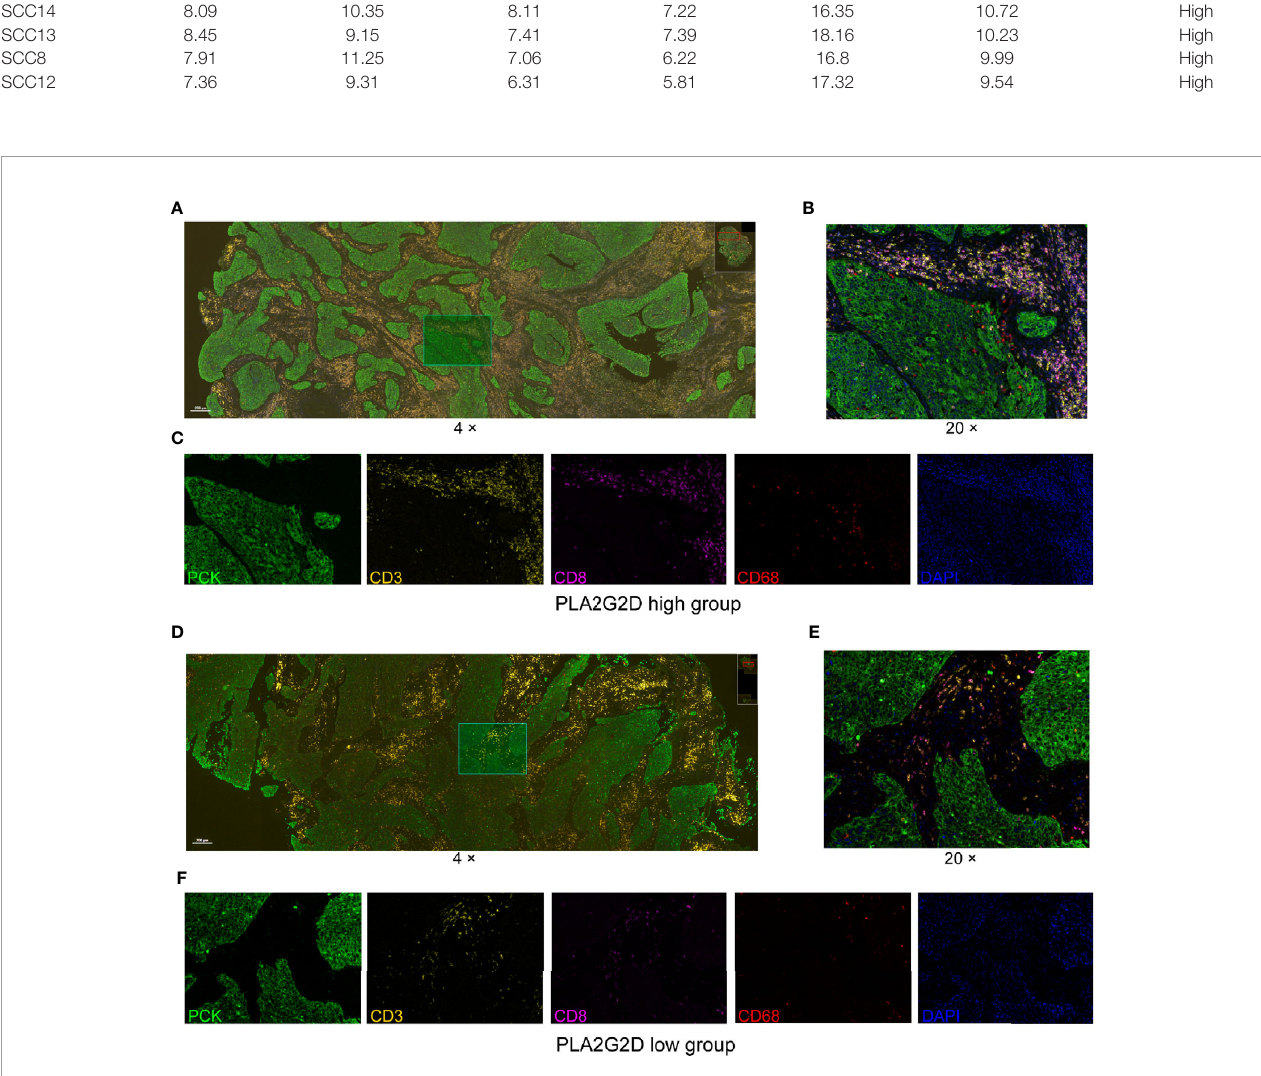
FIGURE 6 | mIHC staining for CD3, CD8, CD68, PCK, and DAPI in cervical squamous cancer specimens with high (A – C) and low expression (D – F) of the PLA2G2D gene. (A, D) Merged mIHC images at low magni fi cation (×4). (B, E) Merged mIHC images at high magni fi cation (×20) indicating the same fi led in (A, D) . (C, F) Single spectral images indicating the same fi led in (B, E)